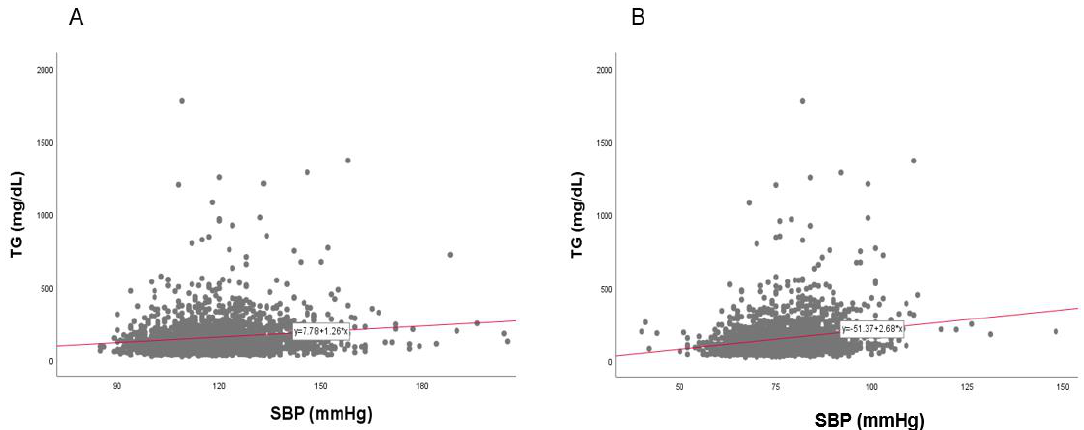
Figure 15. Pearson’s correlation analysis between triglyceride (TG) and systolic blood pressure (SBP) in men ( A ) and women ( B ). The men ( A ) showed r = 0.144 ( p < 0.001) and women ( B ) showed r = 0.211 ( p < 0.001) between SBP and TG.